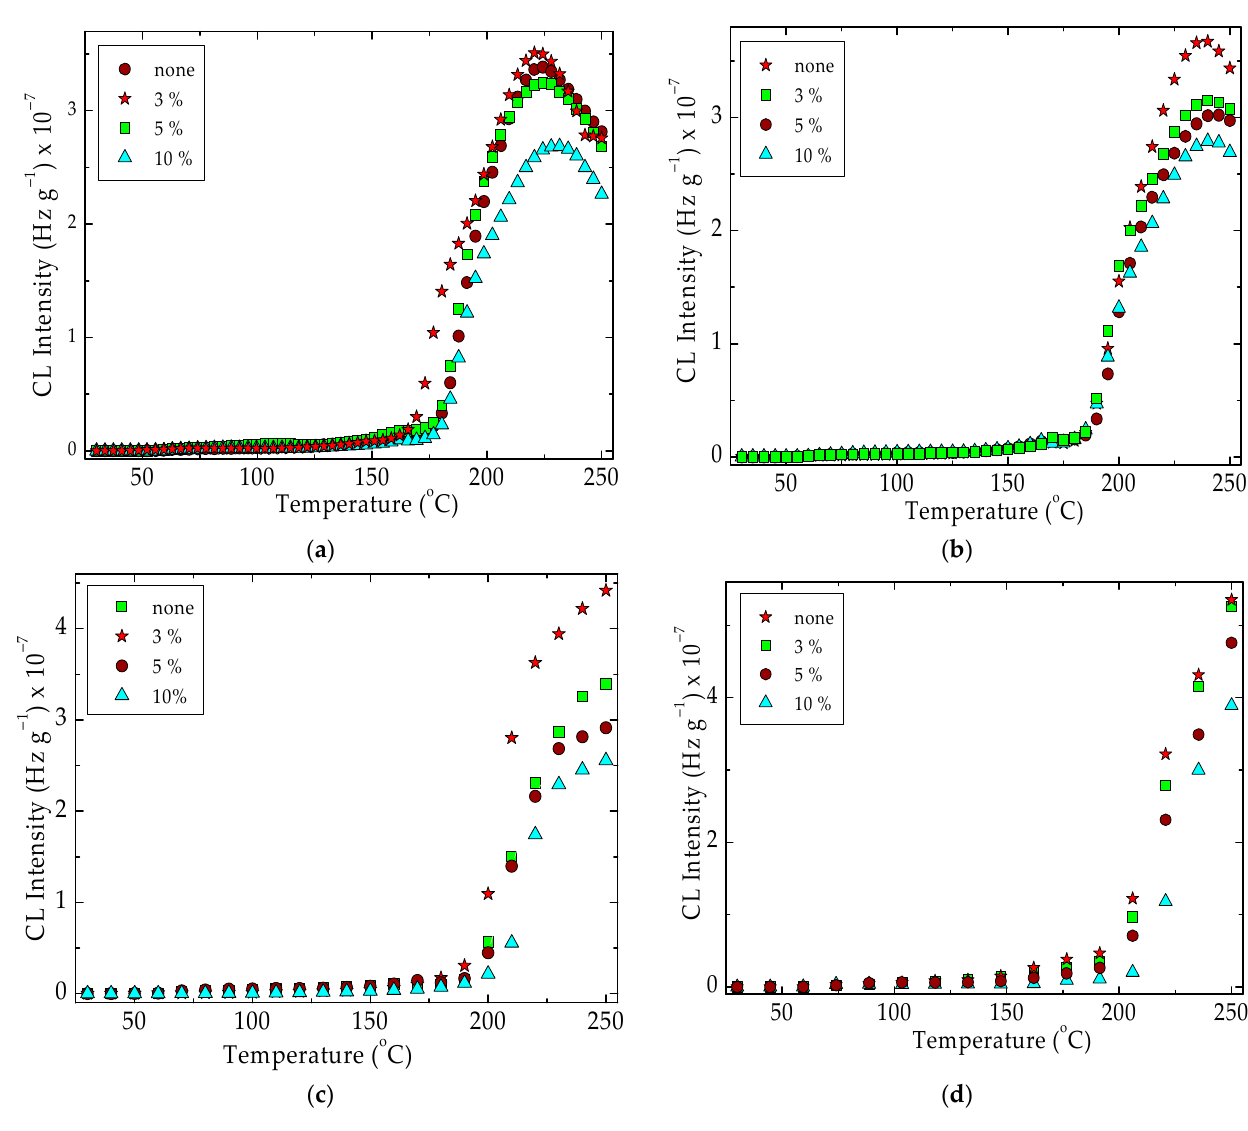
Figure 6. Nonisothermal CL spectra drawn for unirradiated PLA/SIS 30 in the presence of silica after receiving 25 kGy. Heating rates: ( a ) 3.7 °C min − 1 ; ( b ) 5 °C min − 1 ; ( c ) 10 °C min − 1 ; ( d ) 15 °C min − 1 .